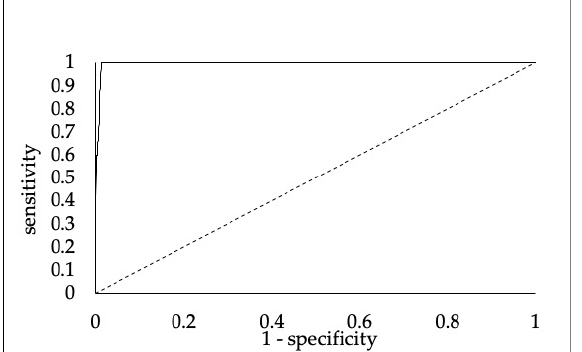
Figure 10. ROC curve results of the shadow detection